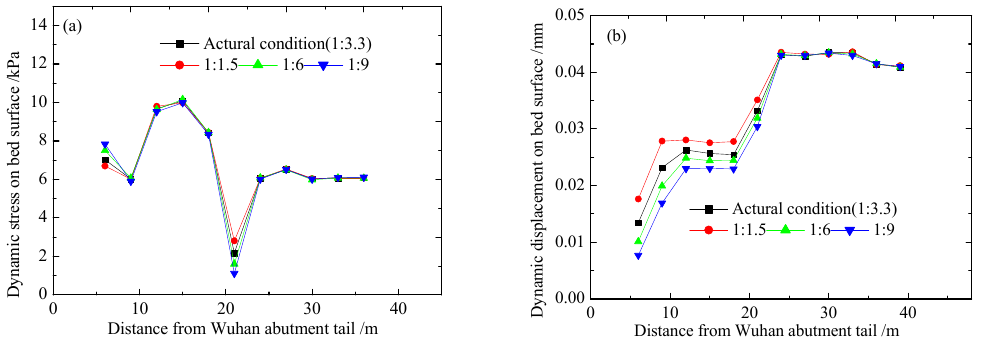
Figure 9. Effect of stiffness change on dynamic response of subgrade surface layer: ( a ) dynamic stress; ( b ) dynamic displacement.